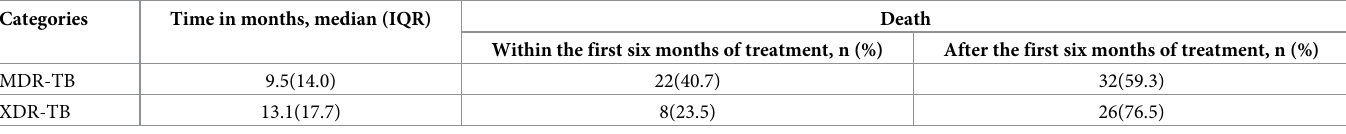
Table 5. Treatment duration until patient death among multidrug-resistant and extensively drug-resistant tuberculosis patients in cases where death was reported (n = 88).